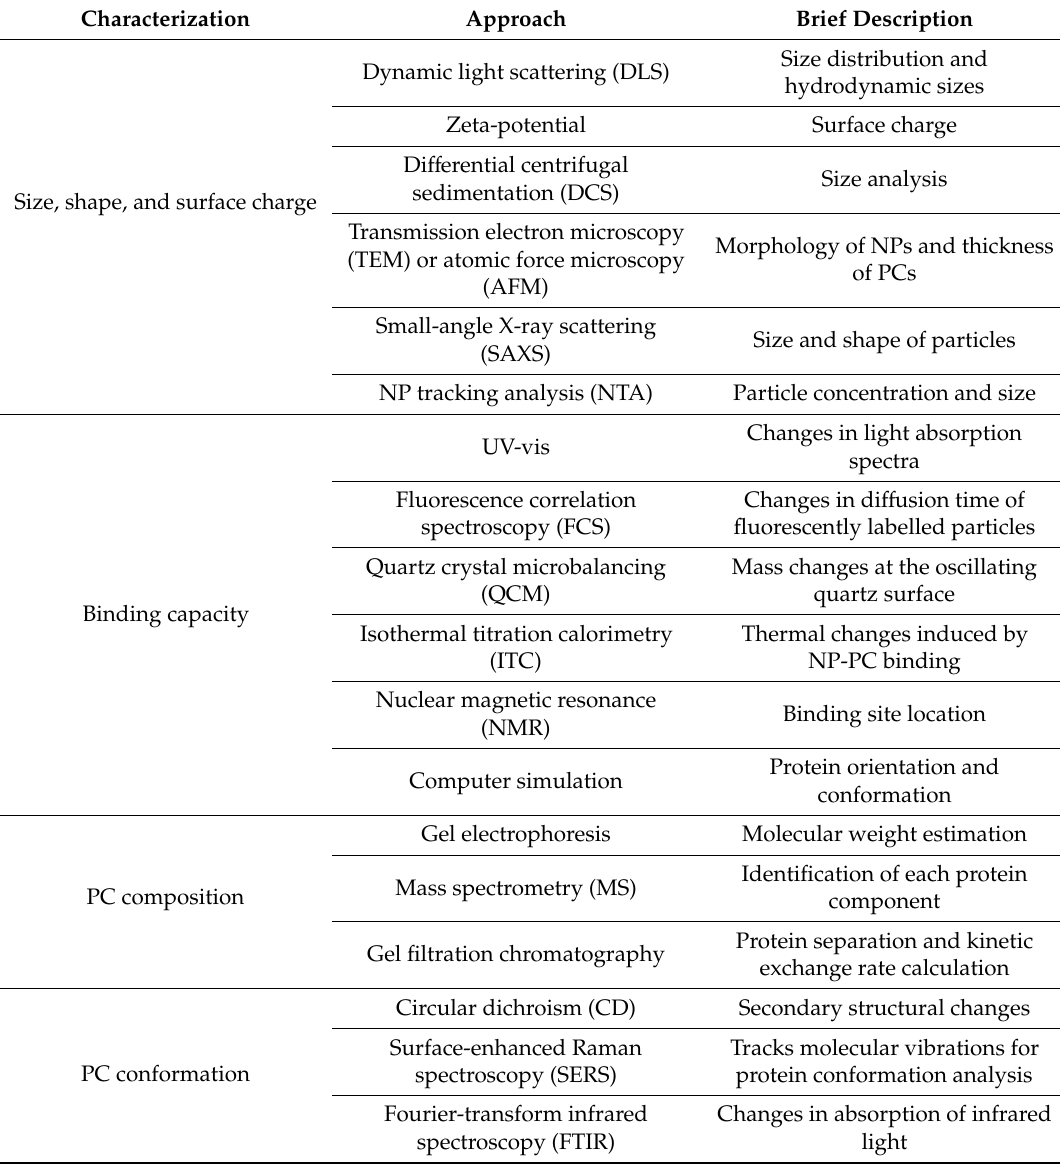
Table 1. Approaches for characterizing nanoparticle–protein corona (NP-PC)